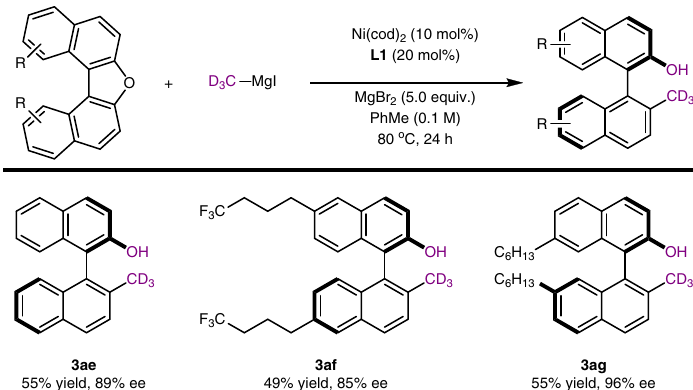
Fig. 5 Rational expansion for the synthesis of deuterated axially chiral compounds of type A. The reactions were carried out by using C – O electrophiles (1.0 equiv.), CD 3 – MgI (4.0 equiv.), Ni(cod) 2 (10 mol%), L1 (20 mol%), MgBr 2 (5.0 equiv.) in PhMe (0.1 M) at 80 °C for 24 h. Isolated yields were reported, ee was determined by using chiral